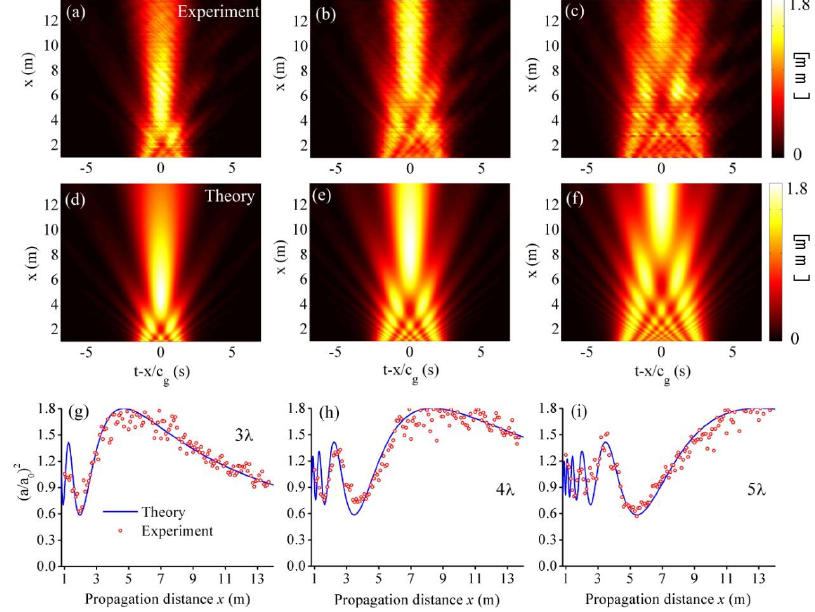
Figure 15. Observation of diffractive focusing phenomenon of rectangular surface water-wave packet with different width: ( a , d , g ) t 0 = 4.18 s; ( b , e , h ) t 0 = 5.58 s; and ( c , f , i ) t 0 = 6.98 s. The incident amplitude is a 0 = 6 mm. ( a – c ) Experimental results representing the normalized intensity evolution ( | a / a 0 | 2 ) of the wave packets along the tank; while ( d – f ) illustrate the corresponding theoretical results. = 0) intensity variation of the wave ( g – i ) depict the on-axis ( t − x c g